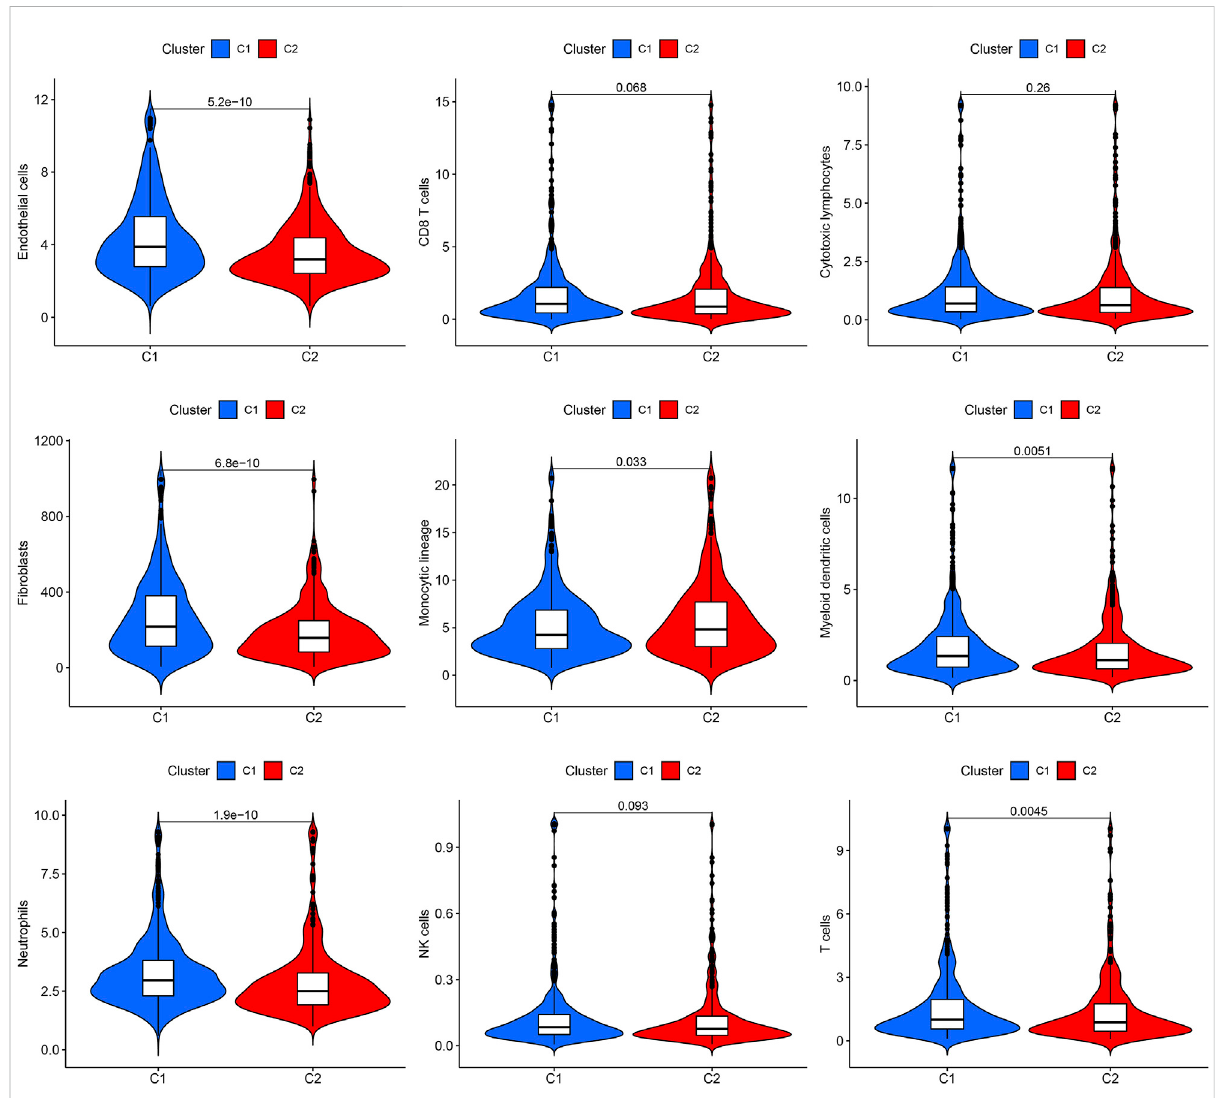
FIGURE 2 Immune cell in fi ltration in the two clusters. Violin plot of endothelial cells, CD8 + T cells, cytotoxic lymphocytes, fi broblasts, monocyte lineage, myeloid dendritic cells, neutrophils, NK cells, and T cells in the two clusters. C1, cluster 1; C2, cluster